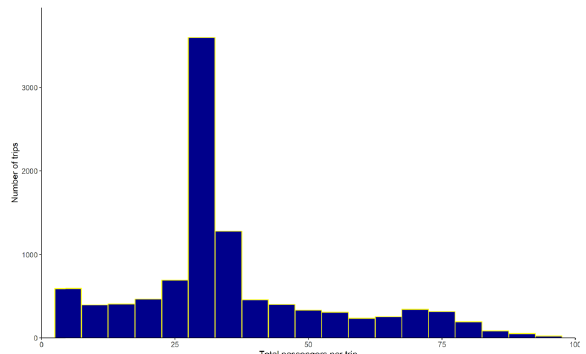
Fig. 1 Distribution of total passengers transported per trip. Source: Own representation, GoMetro Ltd.